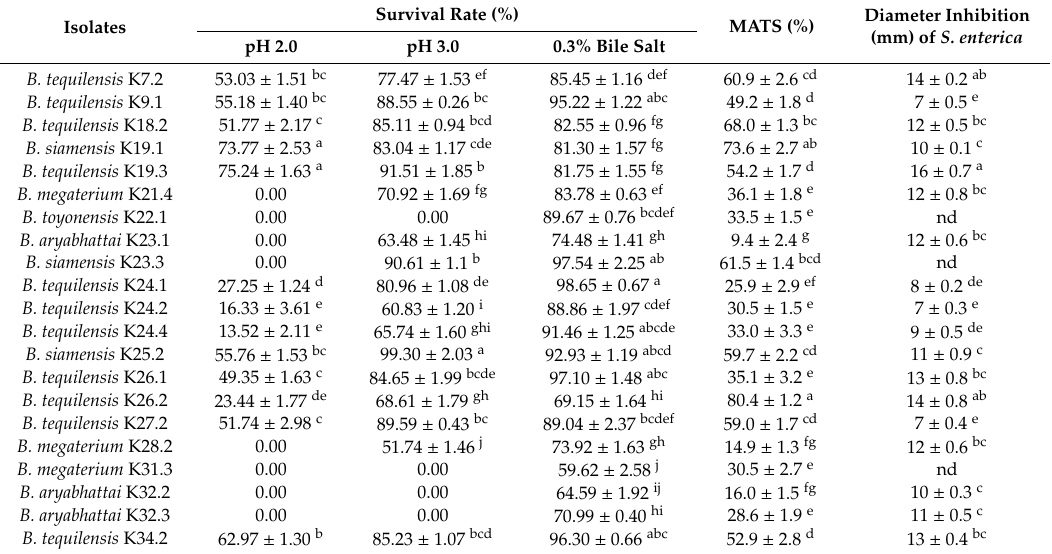
Table 3. Probiotic characteristics of tannin-tolerant Bacillus spp.